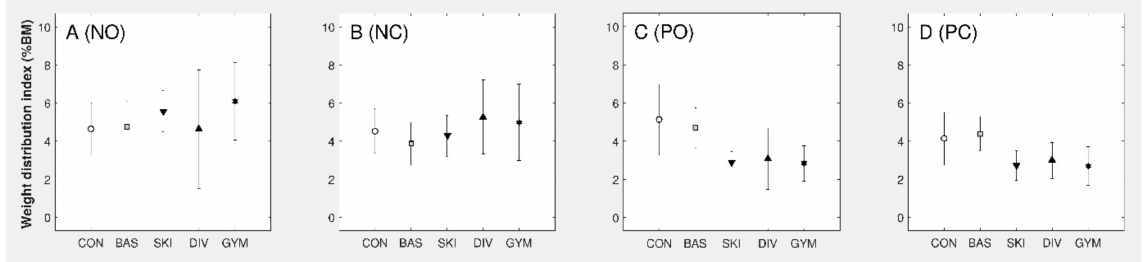
Figure 3. Weight distribution index (WDI) for different sports in positions NO ( A ), NC ( B ), PO ( C ), and PC ( D ). CON— recreational athletes, BAS—Basketball, SKI—Ski Jumping, DIV—Diving, GYM—Gymnastics. Values are given as mean and standard deviation.